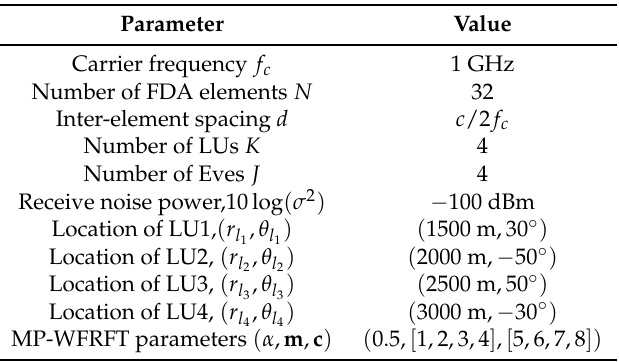
Table 3. Simulation